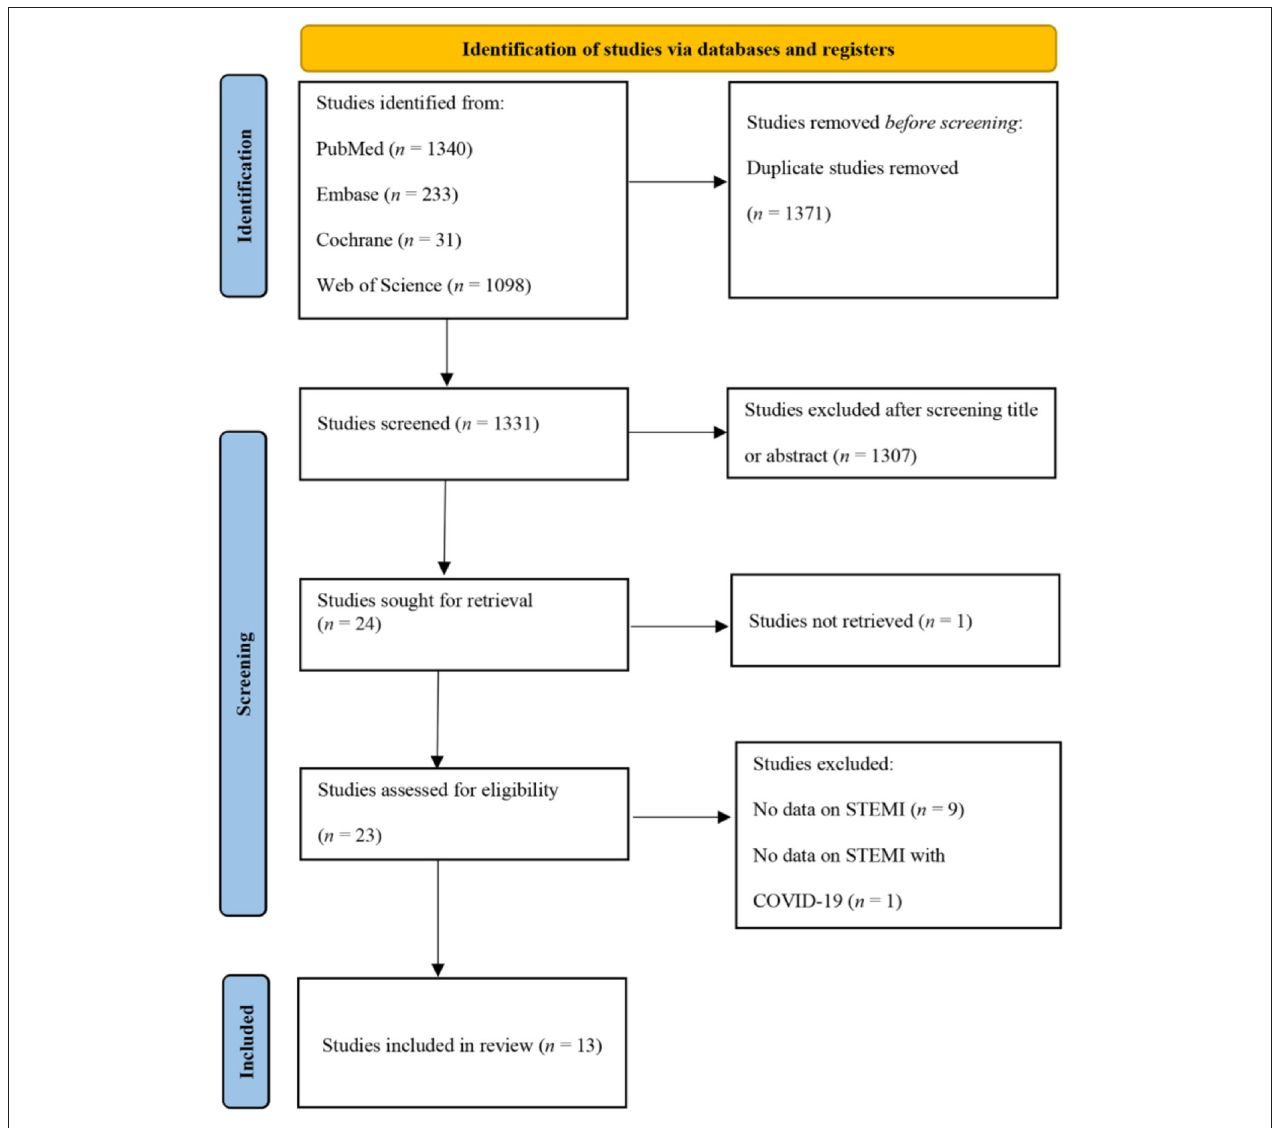
FIGURE 1 | PRISMA flow